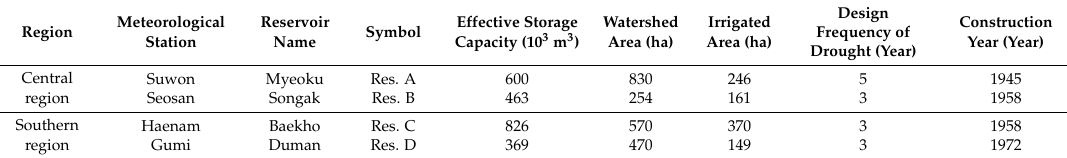
Table 1. Characteristics of agricultural reservoirs in the study area.